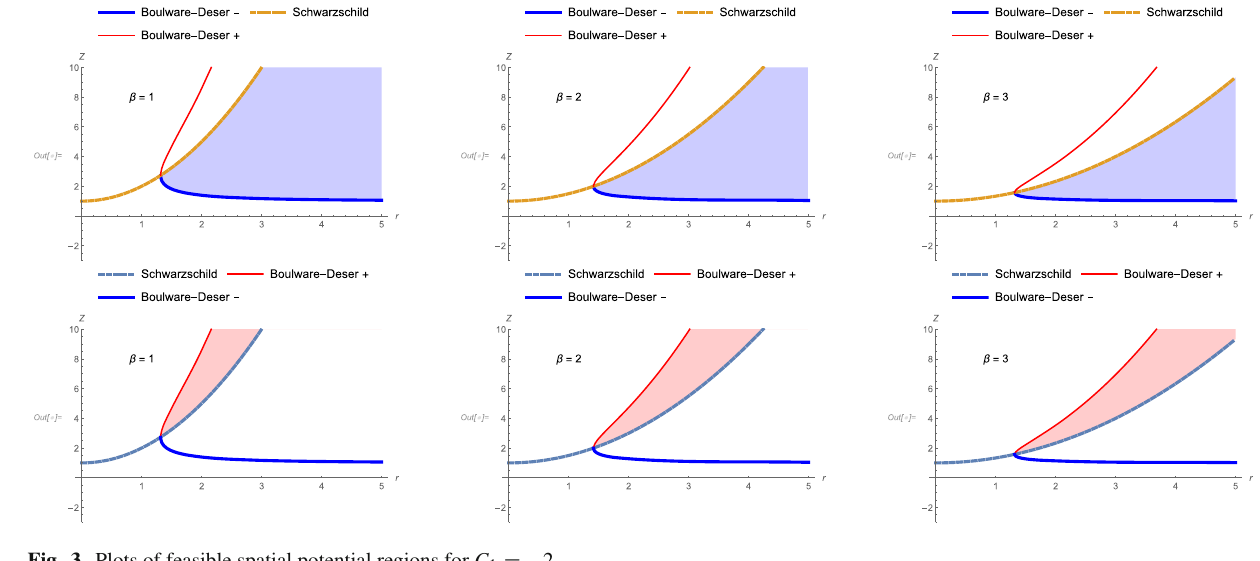
Fig. 3 Plots of feasible spatial potential regions for C 1 = −